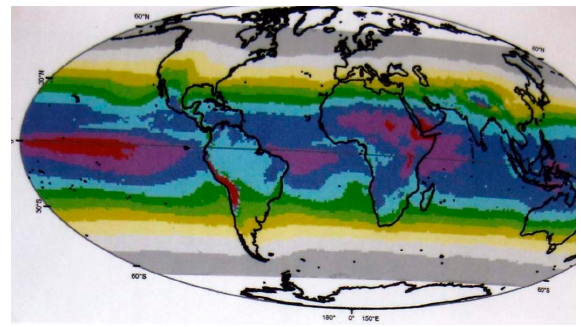
Figure 8. Global distribution of the UV component of sunlight.